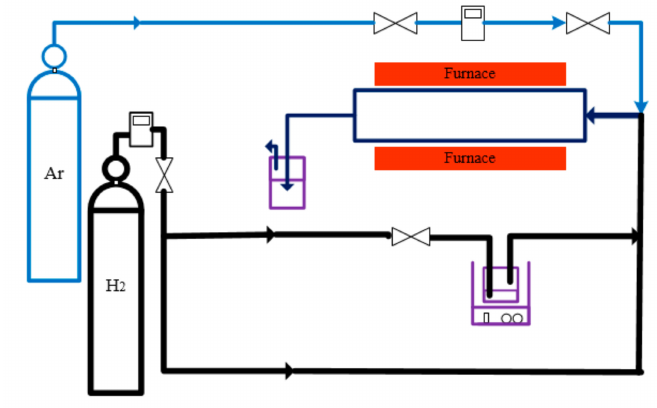
Figure 2. Diagram of the CNT synthesis